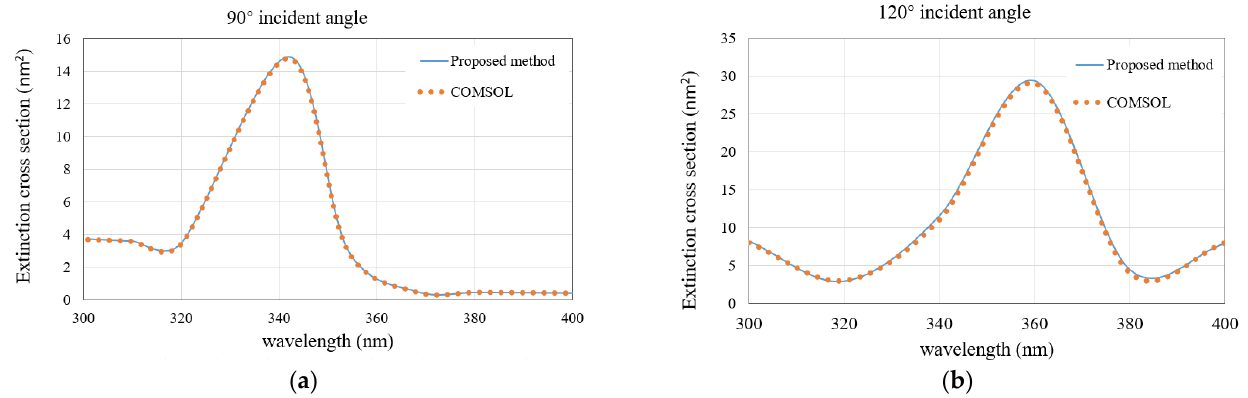
Figure 9. Comparison of the ECS results obtained by the proposed method and the COMSOL software for the nanocylinder array. ( a ) 90° incident angle; ( b ) 120° incident angle. Next, we explored the variations of the ECSs of this nanoarray by fixing the incident angle at 300 nm, 340 nm, and 350 nm, respectively. The variation range of the incident angle is from 0° to 360°. The calculation results of the proposed method are shown in Figure 10. The variation of the extinction cross section with the incident angle shows periodic characteristics for each wavelength.